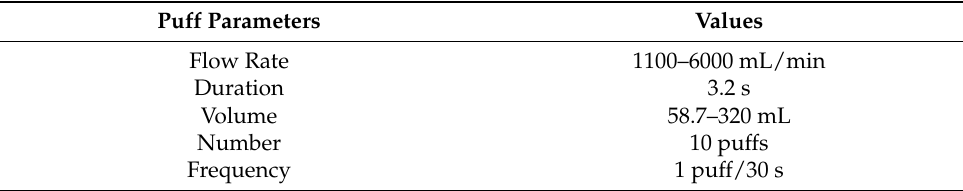
Table 1. Puff3rd Program Parameters. Puff